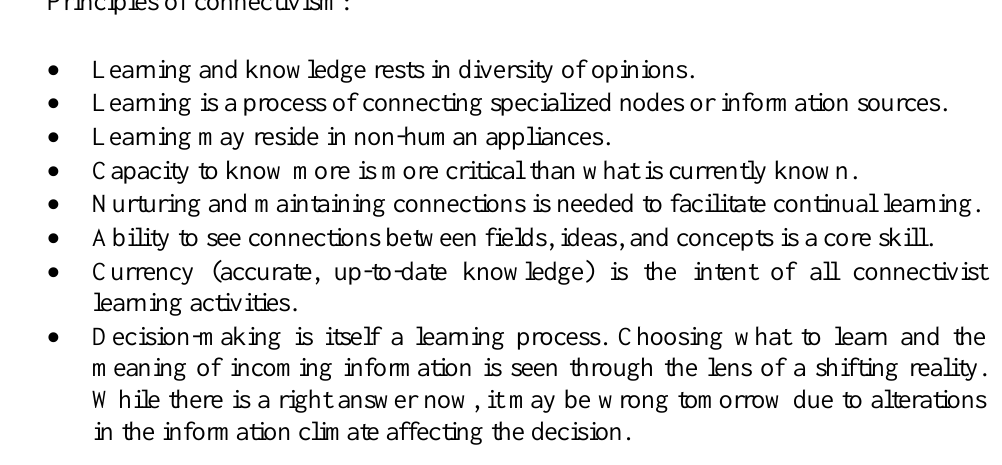
Figure 1. Principles of connectivism (Siemens,